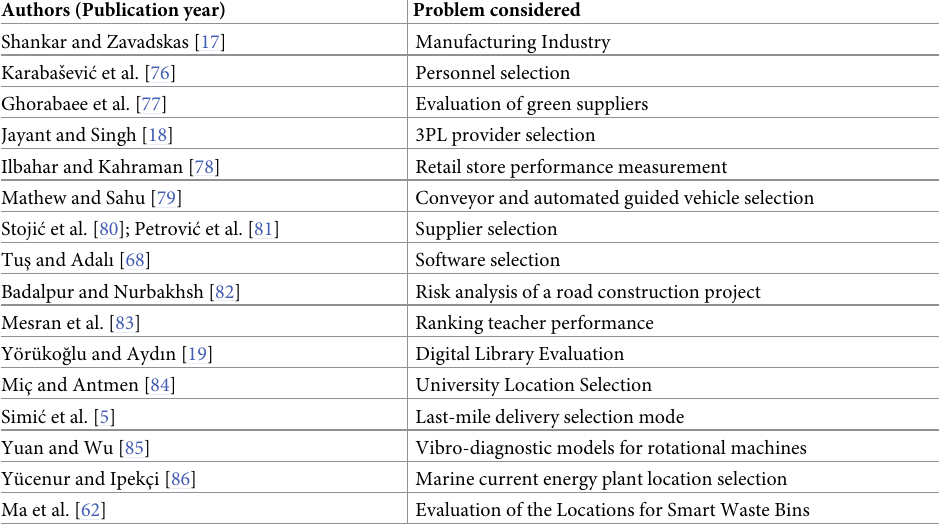
Table 4. Applications of the WASPAS